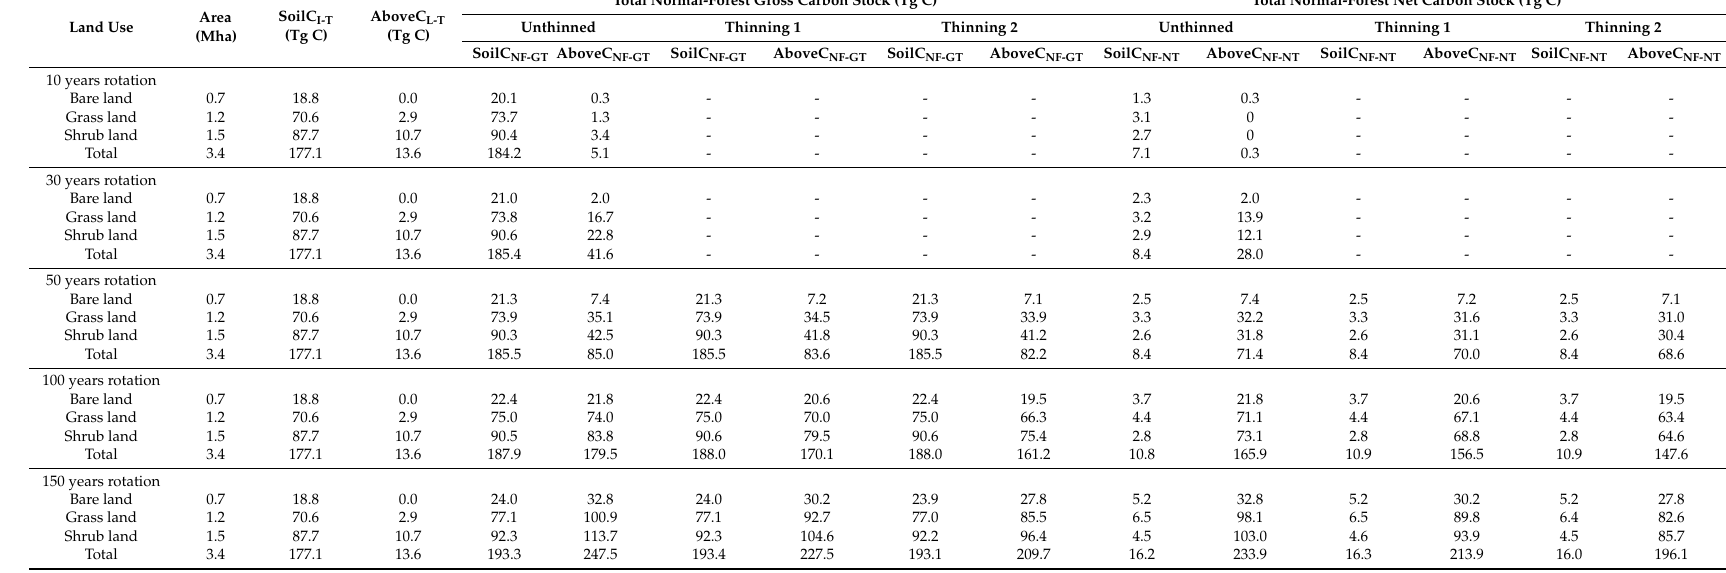
Table 6. Carbon stock sums over the total potential reforestation area in Amhara, i.e., initial soil carbon (SoilC I ) and aboveground carbon (AboveC L ) obtained as described in Table 1, model predicted gross and net soil and aboveground carbon sequestration potential for different ‘Normal-forest’ rotations periods (10, 30, 50, 100, and 150 years) in different land use types and under different managements. All carbon values are in Teragram (Tg C= 10 12 g C). Since, according to our management scenarios, no management is applied in the first two rotation periods (10 and 30, see Section 2.4), we present only